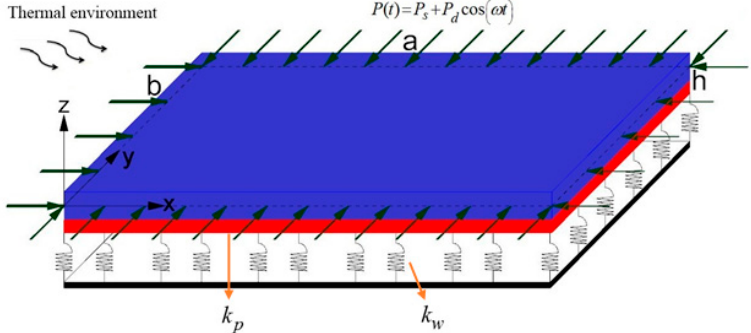
Figure 1. Configuration of the single-layered graphene sheet (SLGS) resting on an elastomeric foundation and subjected to a biaxial periodic compressive loading in a thermal environment.